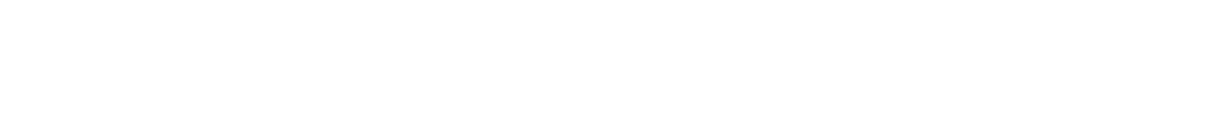
FIGURE 5 | Binding of Sr 2 + , Ca 2 + , and Ba 2 + to alginate . Cross linking between ions and G-G and M-M or G-M blocks of alginate occurs in specific conformations, (A) Sr 2 + binds to G-G blocks solely, (B) Ca 2 + binds to G-G and M-G blocks, and (C) Ba 2 + binds to G-G and M-M